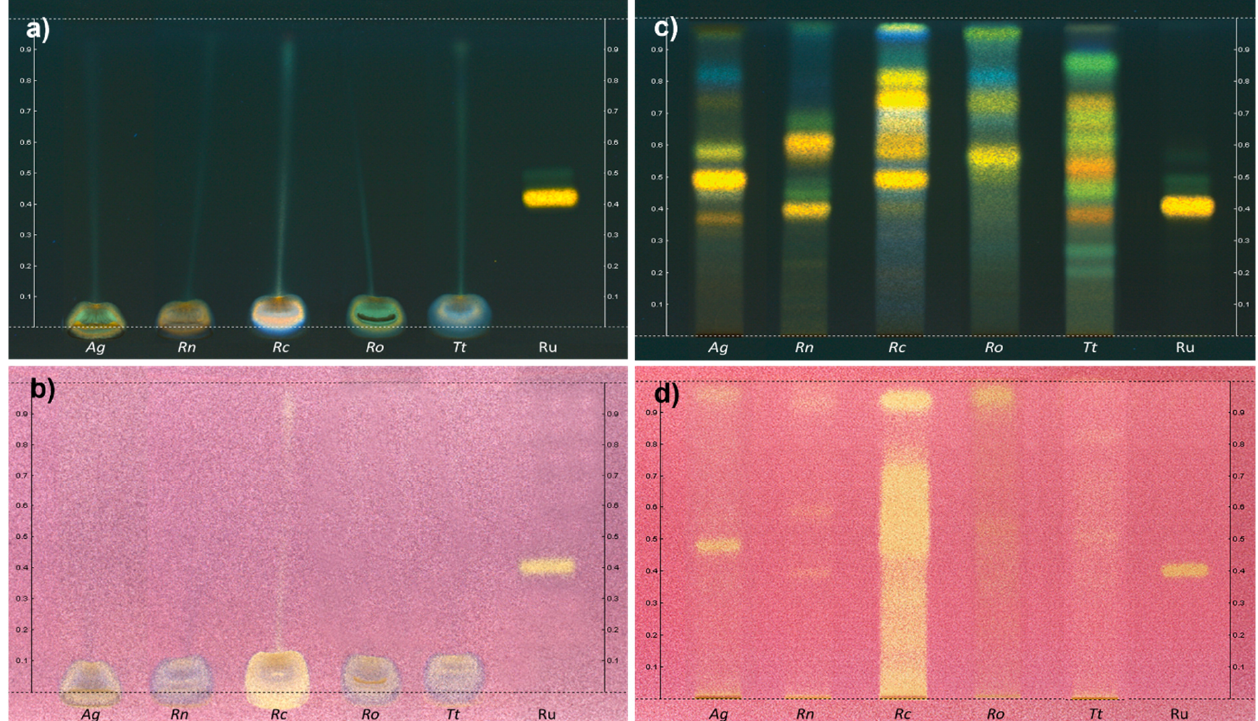
Figure 3. TLC profiles of the five CBMs respectively with Neu reagent and DPPH solution before SPE ( a , b ) and after SPE ( c , d ) ( Ag : Alnus glutinosa , Rn : Ribes nigrum , Rc : Rosa canina , Ro : Rosmarinus officinalis , Tt : Tilia tomentosa , Ru: rutin as standard).